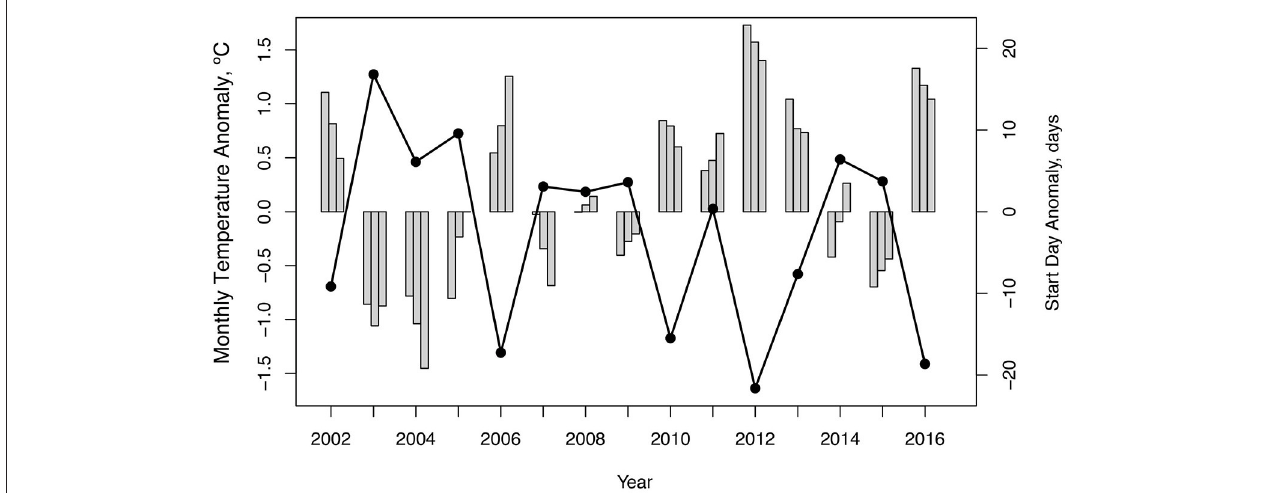
FIGURE 3 | Spring temperatures and start days, 2002–2016. Bars show the monthly temperature anomalies for March, April, and May. The black line plots the start day anomaly from the 2002–2011 mean. The start day anomaly is generally anti-correlated with the spring temperature anomaly.